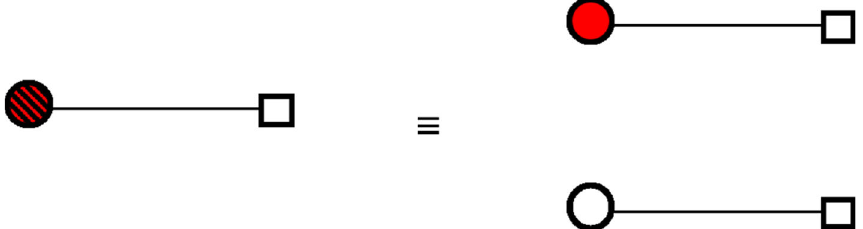
Fig. 3 In the left hand side of this diagram the blue slash filled circle indicates on both types of + and − propagators of massless field δφ in two point function (cid:6) δσ 1 δφ (cid:7) ; this propagators are presented in the right hand side respectively by the blue filled and white empty circles